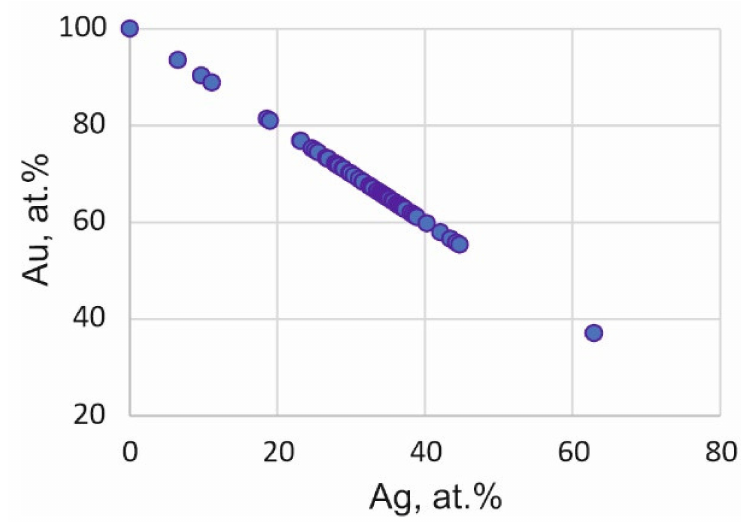
Figure 9. Compositions of Au–Ag alloys (at.%). Table 5. Content of elements in ores and the Content of these elements, recalculated to 100% sulfide, from the Skalisty mine. Northeastern part of the Talnakh intrusion.